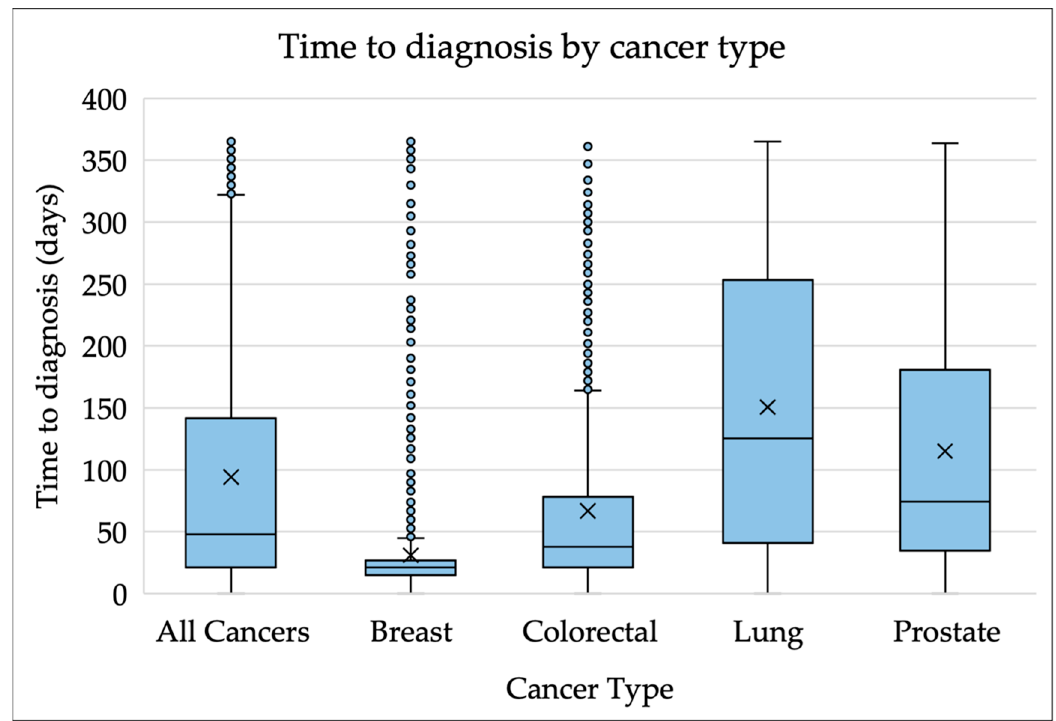
Figure 1. Box plots of time to diagnosis by cancer type. X represents the mean value. Increasing frailty was associated with substantially longer times to cancer diagnosis, with moderate and severely frail patients taking the longest time to reach a diagnosis. 123). The median time to diagnosis was 64 days (IQR 24–193) for patients with mild frailty for patients with severe frailty was 87 days (IQR 24–211). This is shown in Figure 2 (be- low).